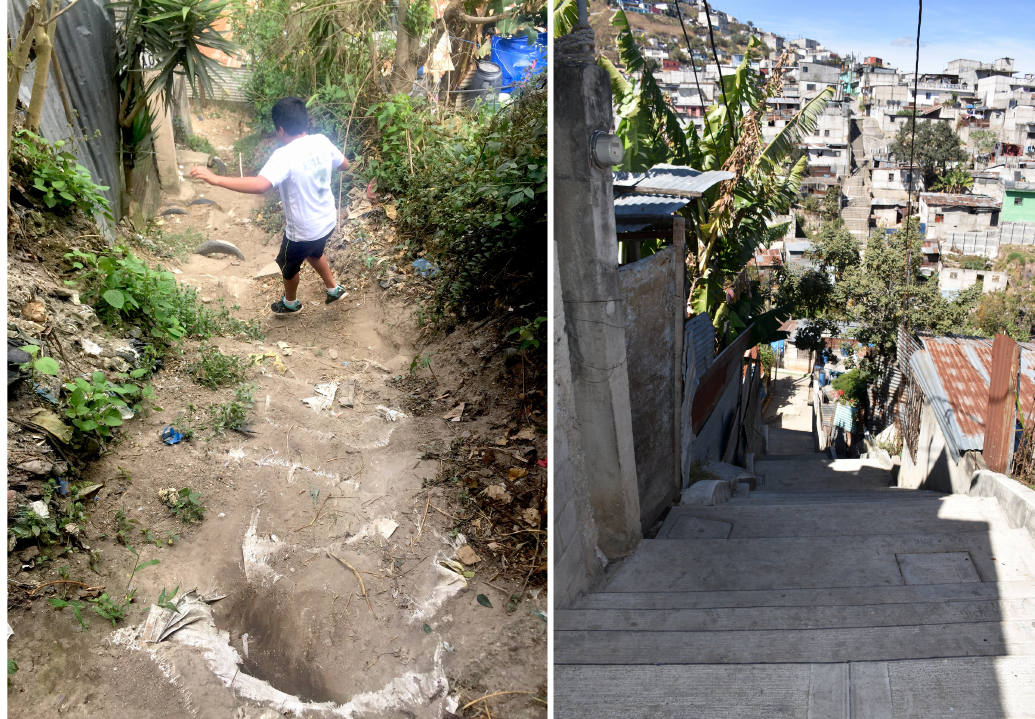
Figure 7. Contrast between the two main streets in Arzú: The cement stairs were built by active residents with the support of the